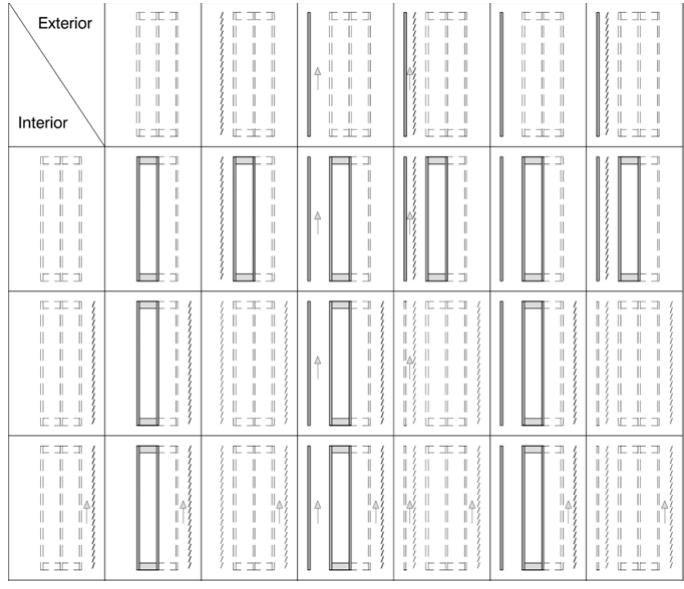
Fig. 7 Overview of different facade construction’s with DGU /